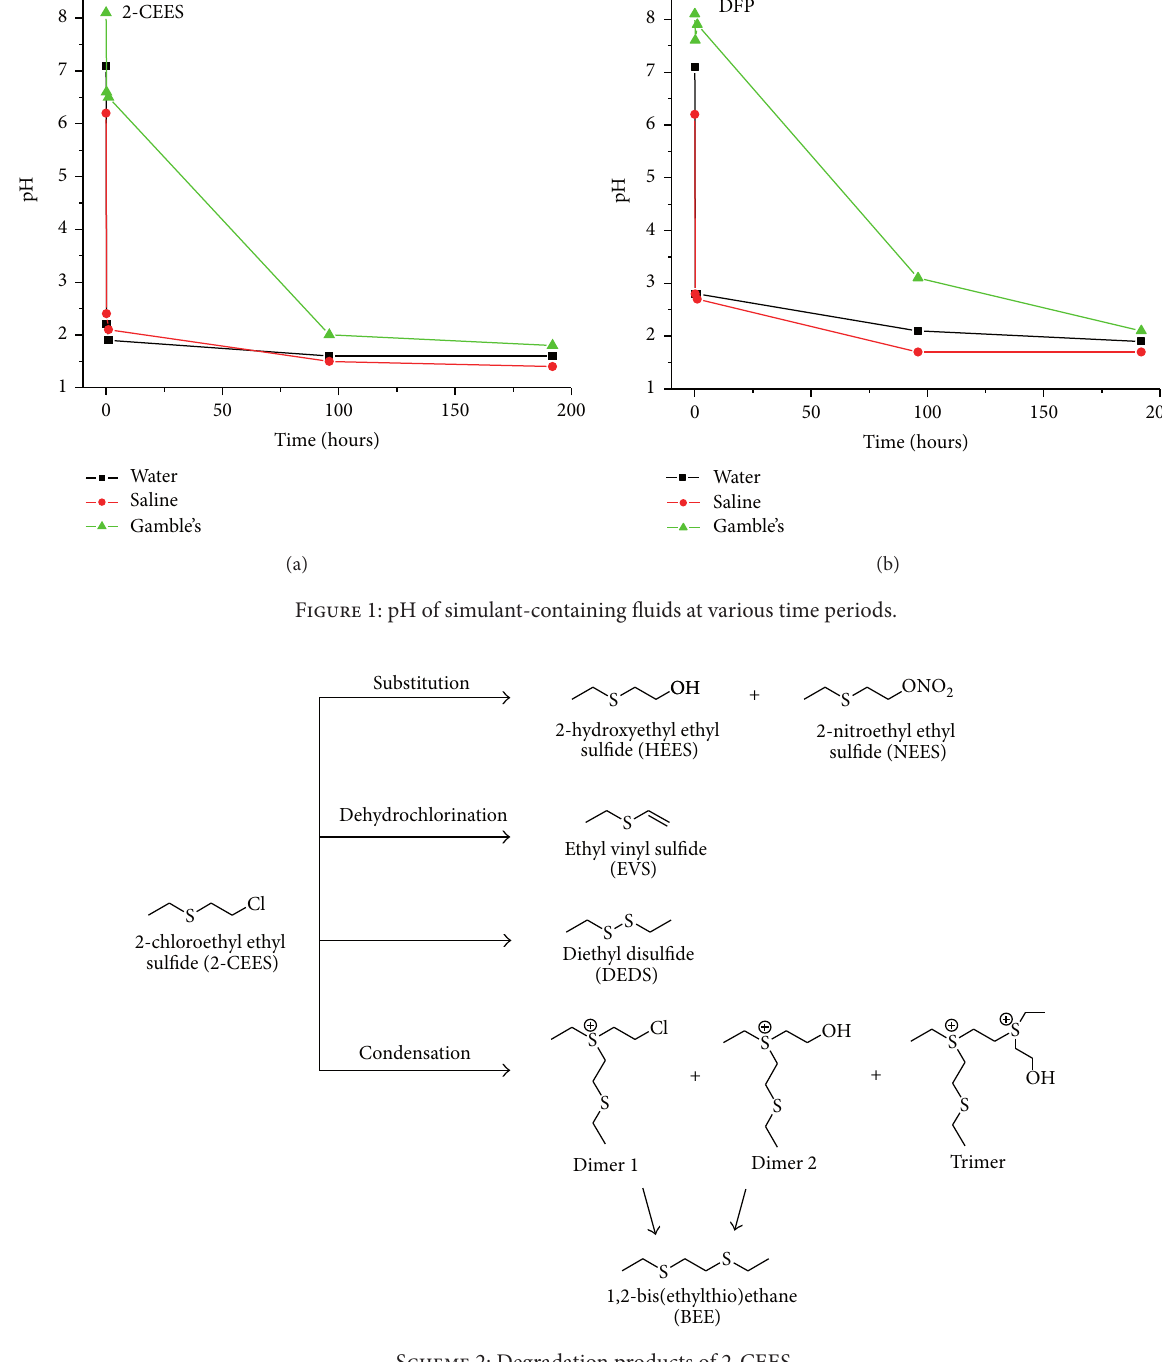
S 2: Degradation products of